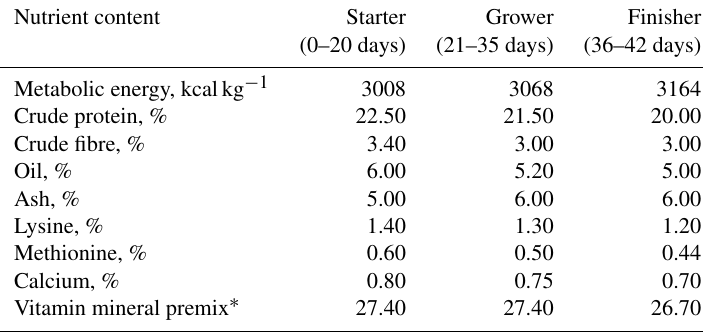
Table 1. The nutrient composition of the experimental diets. Nutrient content Starter Grower